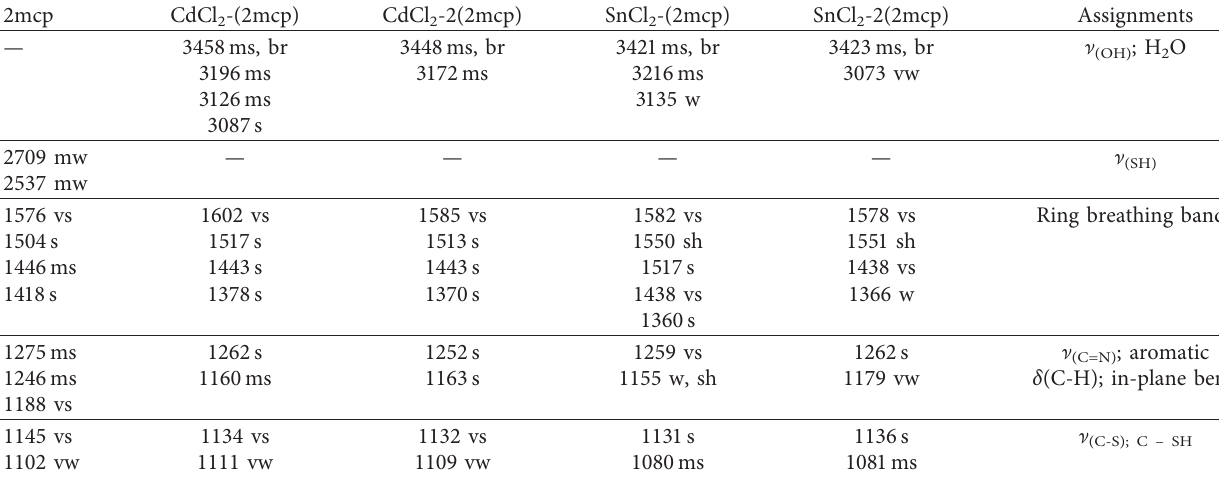
Table 5: Major infrared bands (cm − 1 ) for 2mcp and its Cd(II) and Sn(II)